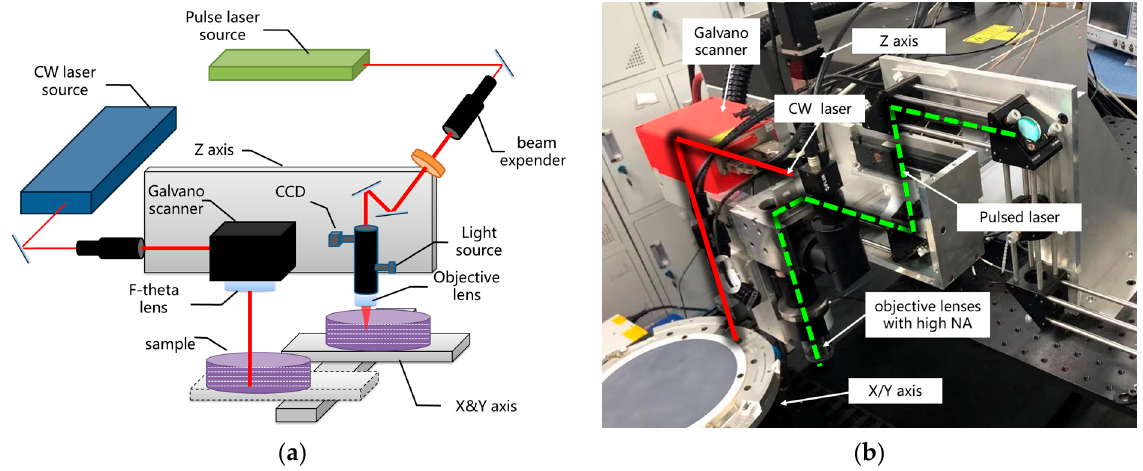
Figure 1. Configuration of a dual laser beam asynchronous dicing system: ( a ) schematic diagram of experimental set-up; ( b ) experimental platform with dual laser path.